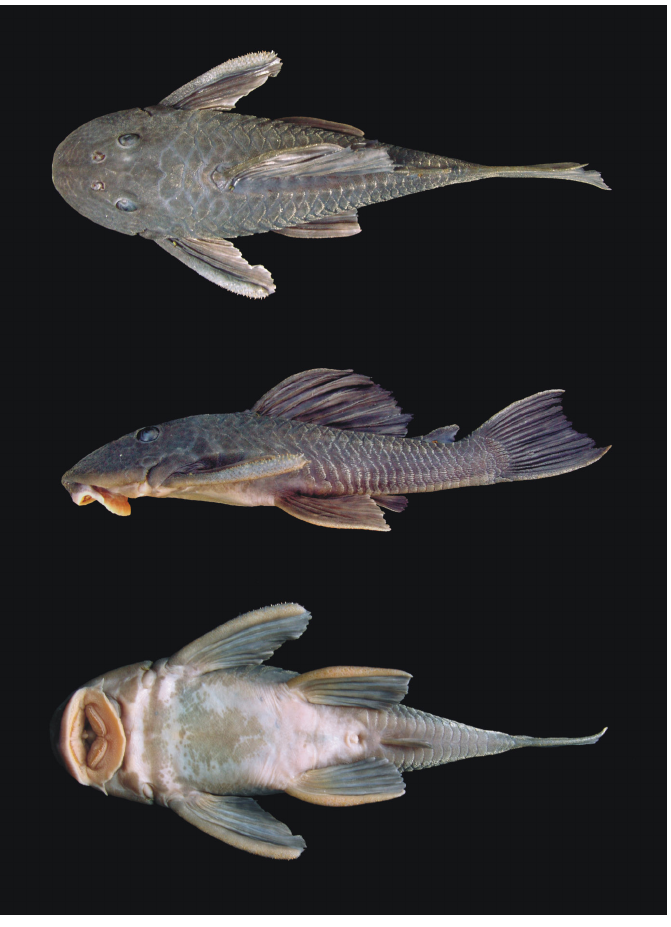
FIGURE 5 | Hypostomus robertsoni , holotype, NUP 22740, 127.9 mm SL; Brazil, Paraná State, Marialva, Keller River, tributary of Ivaí River, Upper Paraná River basin. Dorsal, lateral and ventral